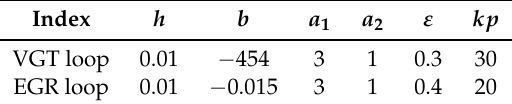
Table 1. NLADRC controller parameters.